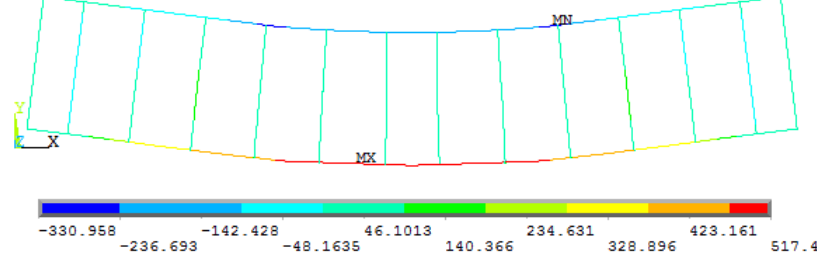
Figure 11. Crack Patterns for Group (3). ( a ) One-Pont Load. ( b ) Two-Point Loads ( c ) Distributed Load on Four Points.